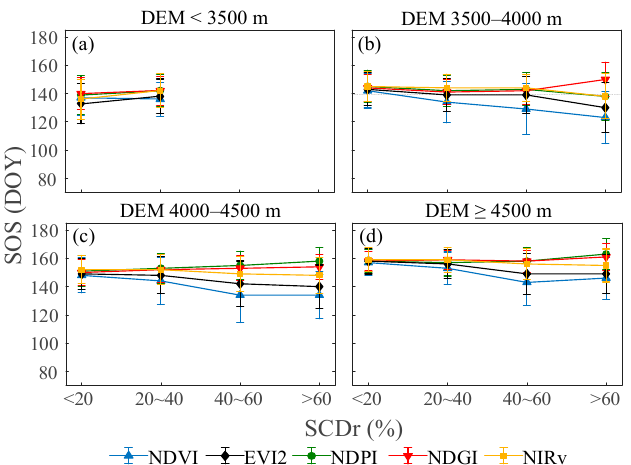
Figure 15. Error bars of the SOS detected by five different VIs for different SCDr intervals at each elevation zone. Error bars show the mean and standard deviation of the SOS in each case. ( a – d ) are the statistical distribution of SOS detected from the five VIs at different SCDr and elevation zones.